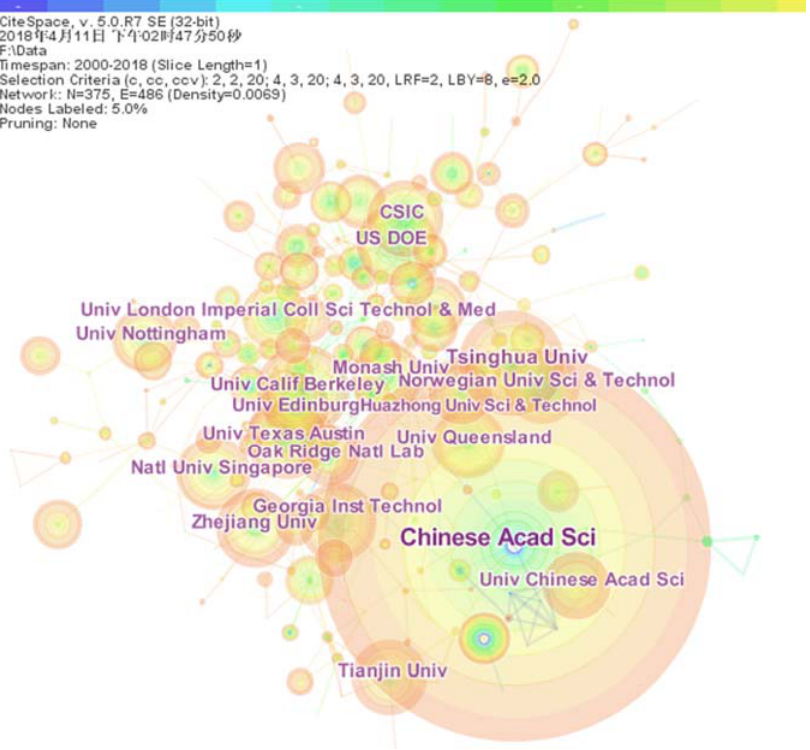
Figure 3. Mapping on the co ‐ occurring network of institutions.